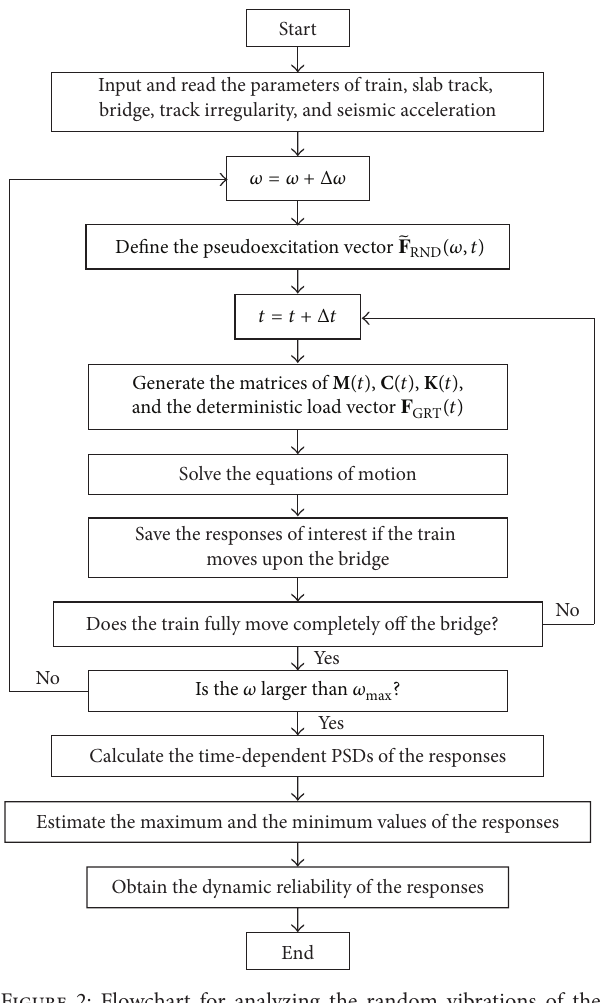
Figure 2: Flowchart for analyzing the random vibrations of the TSTBI